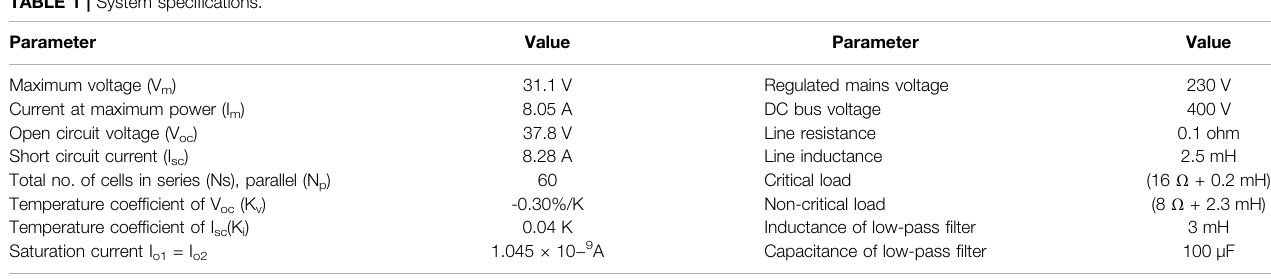
TABLE 1 | System speci fi